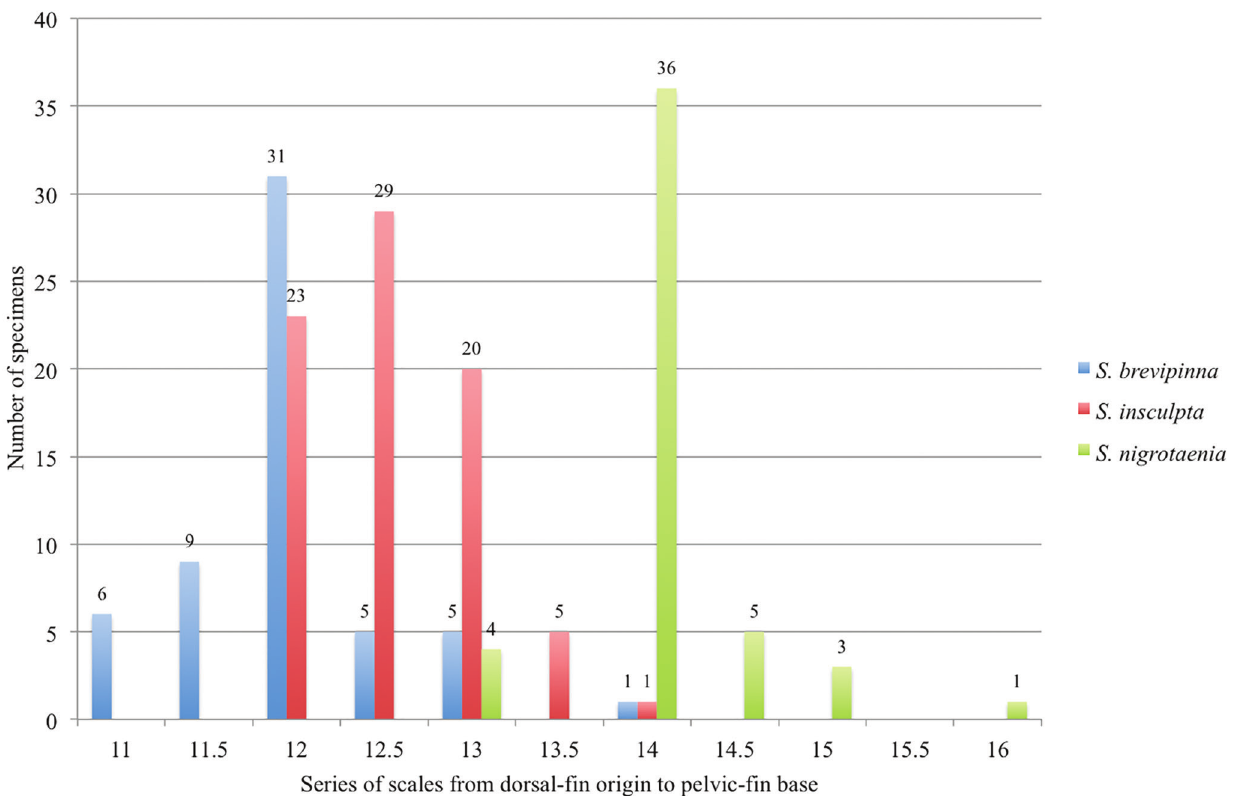
Fig. 4. Histogram of number of series of scales from dorsal-fin origin to pelvic-fin base against number of specimens of Steindachnerina brevipinna , S. insculpta and S. nigrotaenia